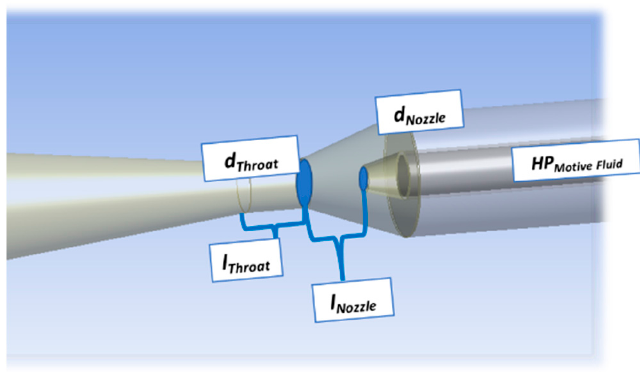
Figure 5. Variables involved in the optimization process [2].